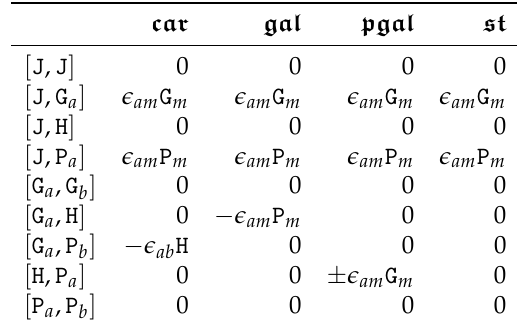
Table A2. Carroll, Galilei, para-Galilei and static algebra. The upper sign is for AdS (and contractions thereof) and the lower sign for dS (and contractions